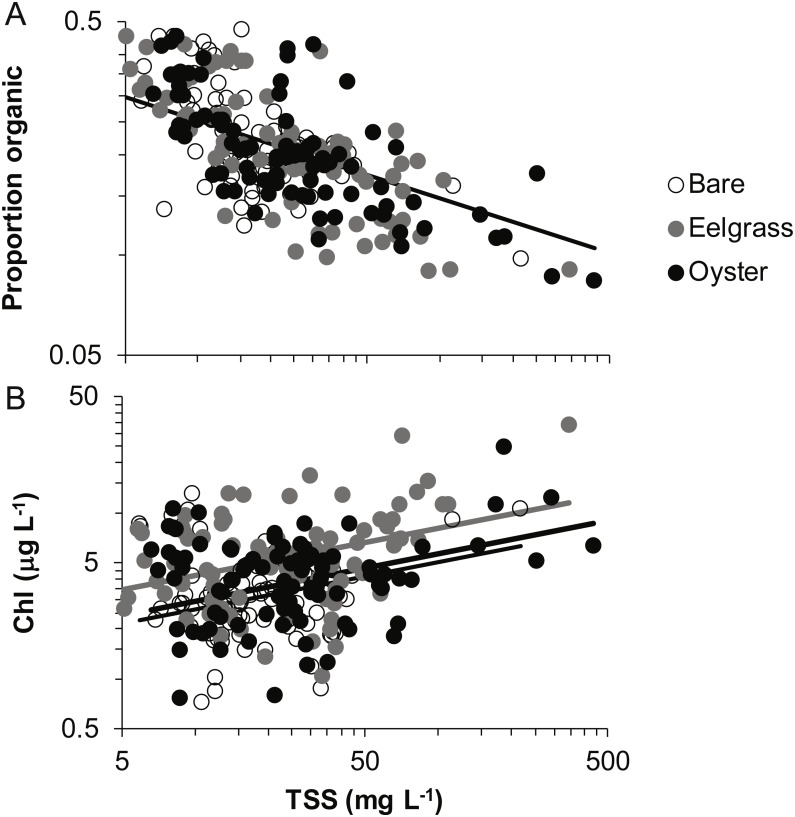
Quality of seston in shallow water during drifts over three intertidal habitat types at five sites in Washington State, USA.(A) Organic content, and (B) Chlorophyll-a concentration in water varying in total suspended solids. Samples include both initial and final measurements for each drift. Lines are plotted from coefficients of linear mixed effects models including factors significant at α < 0.05. Accordingly, a single relationship is shown for proportion organic, where habitat was not significant, but separate lines for chlorophyll-a due to water over eelgrass containing higher concentrations than over bare.